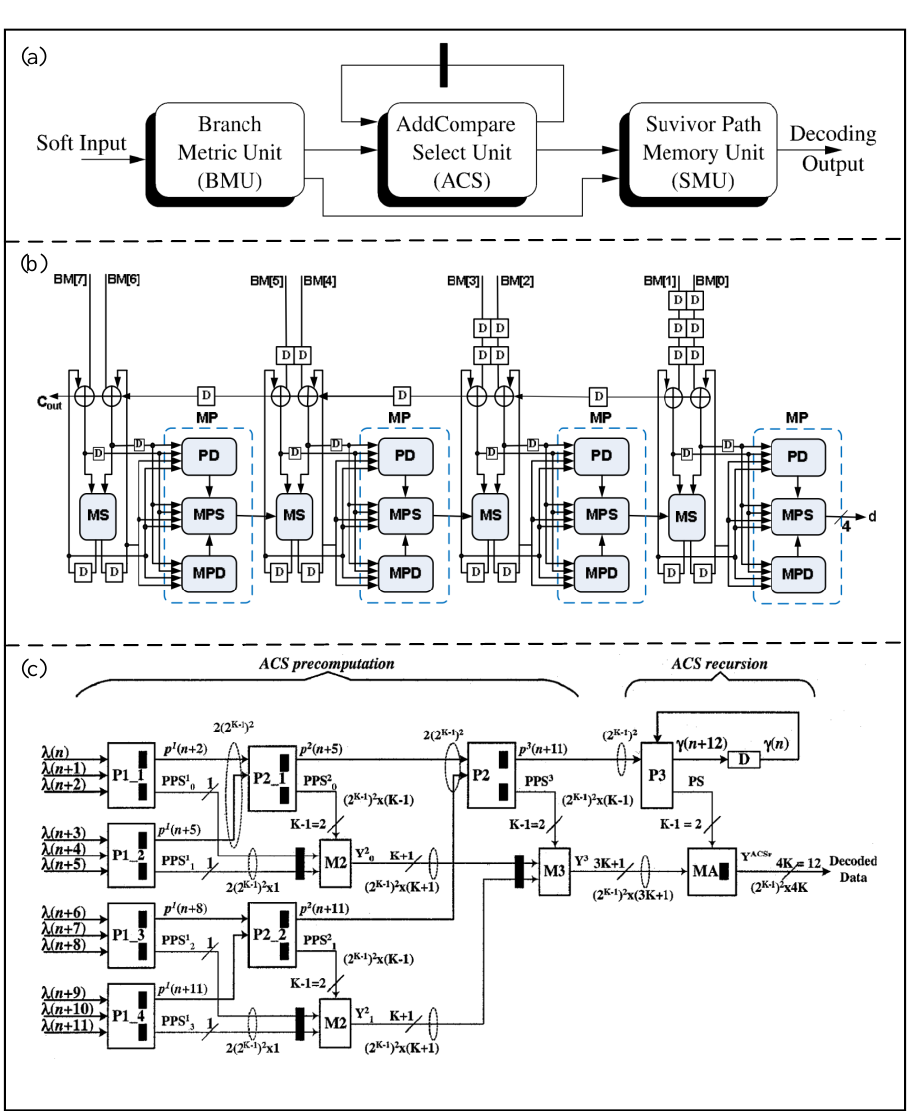
Figure 10. ( a ) Basic computation units in a Viterbi decoder. (Reprinted from [65], Copyright 2004, with permission from IEEE). ( b ) Block diagram of the proposed two − bit level pipelined MSB − first ACSU. (Reprinted from [66], Copyright 2008, with permission from IEEE). ( c ) An architecture of the low − latency branch precomputation Viterbi decoder. (Reprinted from [67], Copyright 2004, with permission from IEEE).